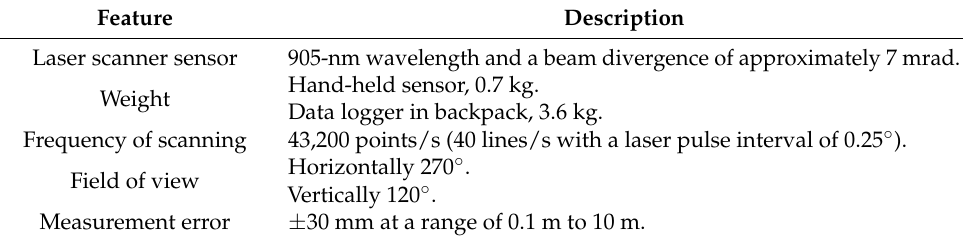
Table 1. Technical specifications of the hand-held mobile laser scanning (HMLS)